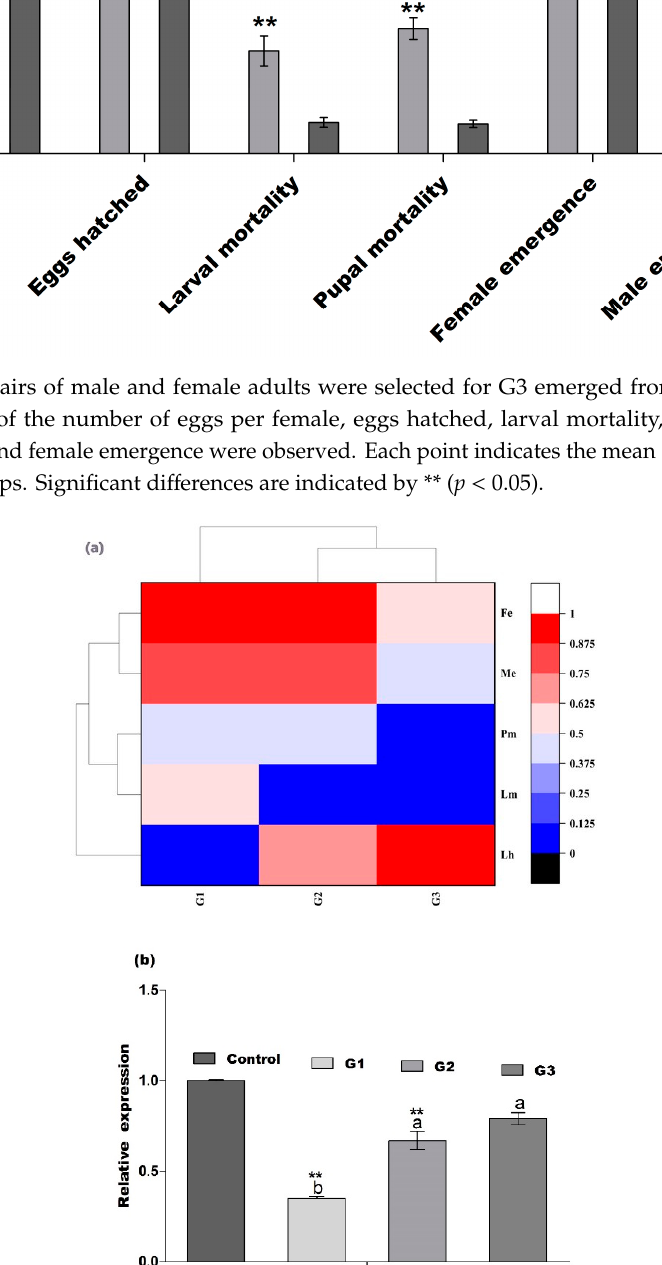
Figure 10. ( a ) Heat map results show the knockdown e ff ects of the CmHK gene in G1, G1, and G3 generations. Lh, Larvae hatched; Lm, Larval mortality; Pm, Pupal mortality; Me, Male emergence; Fe, Female emergence. ( b ) Changes in mRNA transcript levels of CmHK after RNAi in G1, G2, and G3 generations. Each bar indicates the mean ± SD , and significant di ff erences are indicated by ** ( p <